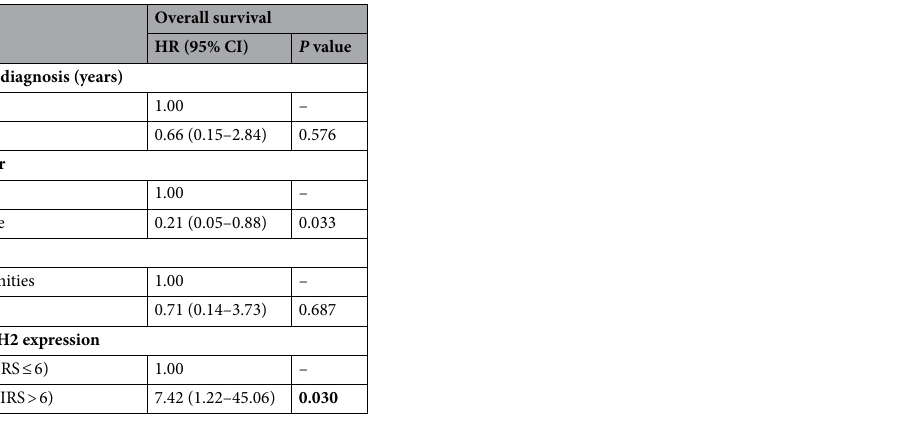
Table 7. Multivariate analysis of metastasis-free survival in osteosarcoma patients and IMPDH2 expression in post-chemotherapy tissues (n = 20).